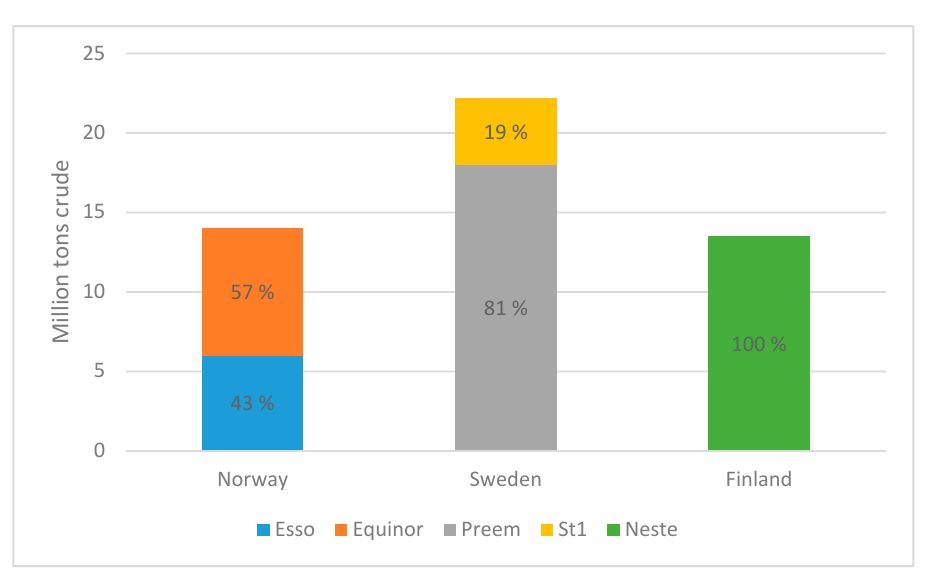
Figure 2. Nordic crude oil refining capacity. Source: [27,34–37].